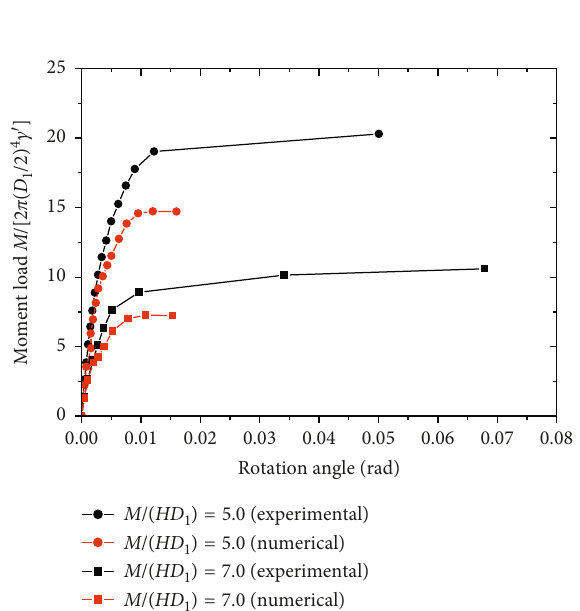
Figure 12: Comparison between test results and numerical results for moment against the rotation angle.